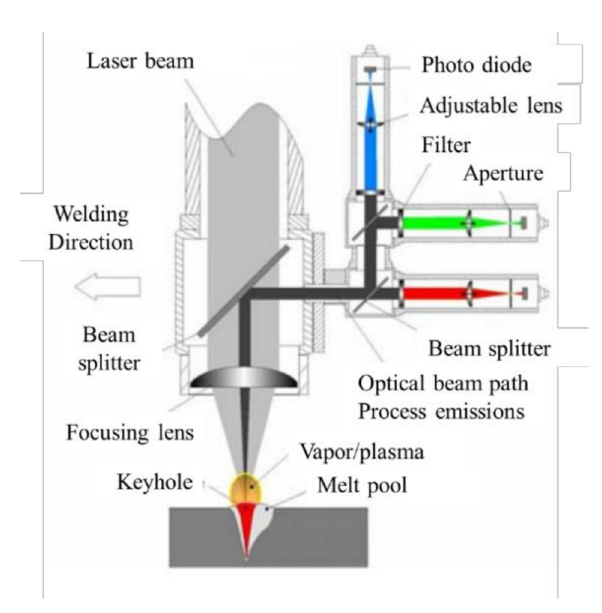
Figure 1. Sensors and laser head of the LWM system.